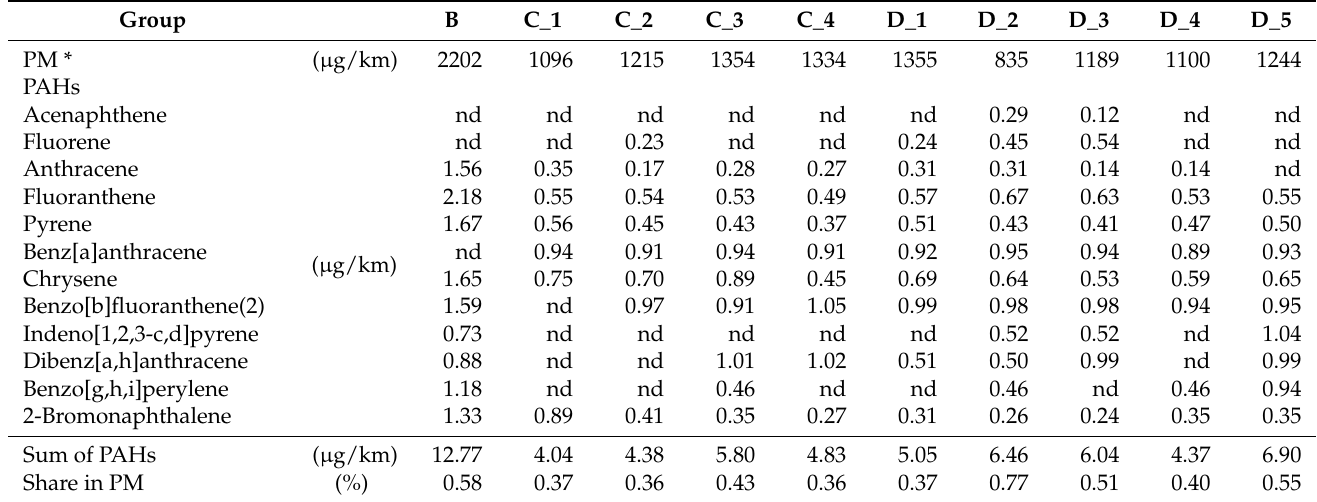
Table 8. Results of the GC-MS analysis of the solid particles from vehicle groups B–D. The emission of studied PAHs is a mean from at least two samples from each group. The PM shows a mean mass of solid particles from vehicles used in this part of the